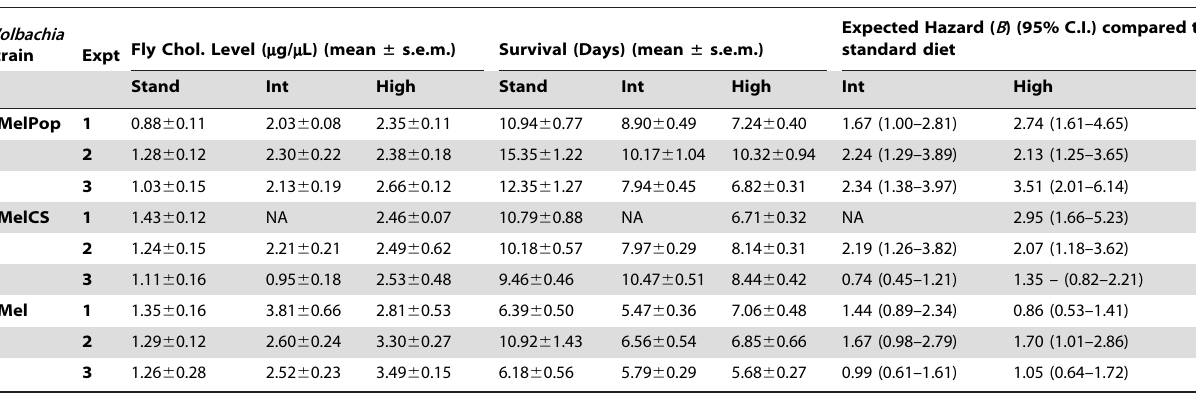
Table 1. Mean survival times, cholesterol levels and hazard ratios for Wolbachia -infected flies across individual experiments.